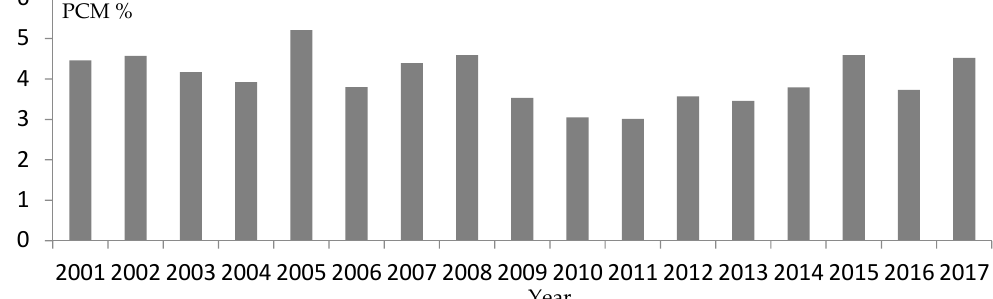
Figure 2. Yearly prevalence of clinical mastitis (PCM %), with physical examination of 144,455 lactating rabbit does on 490 rabbitries, in Spain, and 41 in Portugal.